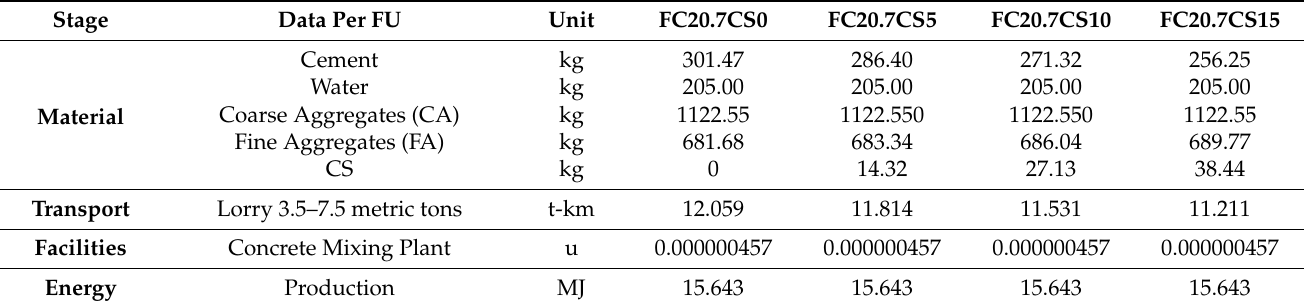
Table 11. Inventory of concrete mixes for 20.7 MPa per 1-cubic-meter functional